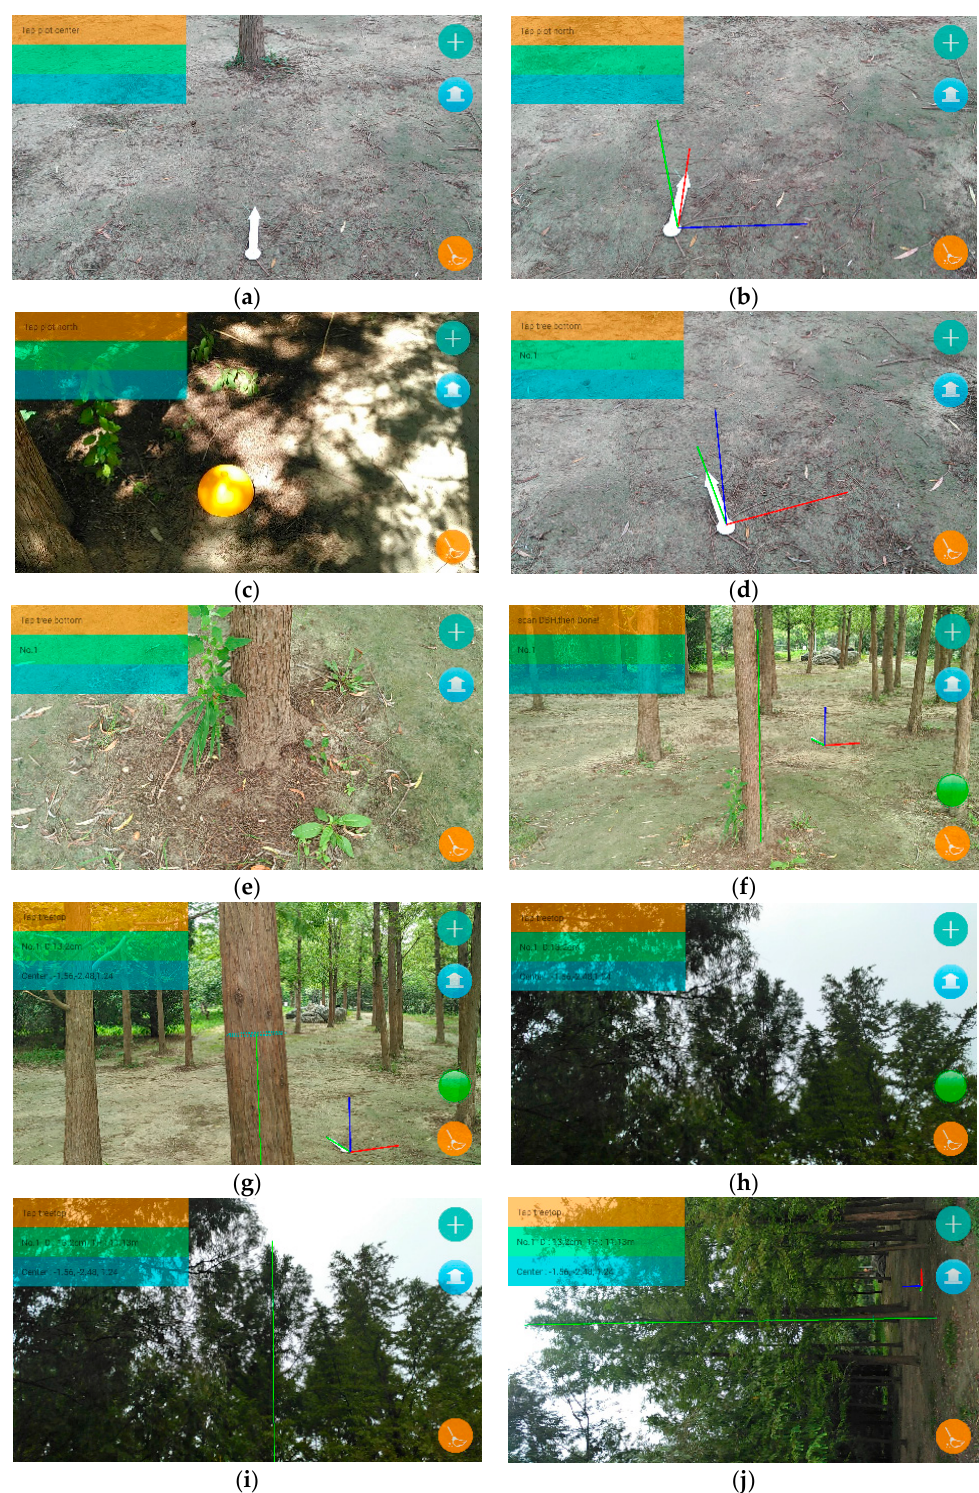
Figure 7. Different states of the SLAM device during the observation process. ( a ) Waiting to tap the plot center on the screen; ( b ) waiting to move towards the north corner of the plot; ( c ) waiting to tap the north corner on the screen; ( d ) completion of the PCS building; ( e ) waiting to tap a bottom point of a tree; ( f ) waiting to scan the breast height section of the tree; ( g ) completion of fitting the circle at breast height; ( h ) waiting to tap the position of the treetop on the screen; ( i ) completion of the estimation of the tree height; ( j ) finished estimating the attributes of the tree.